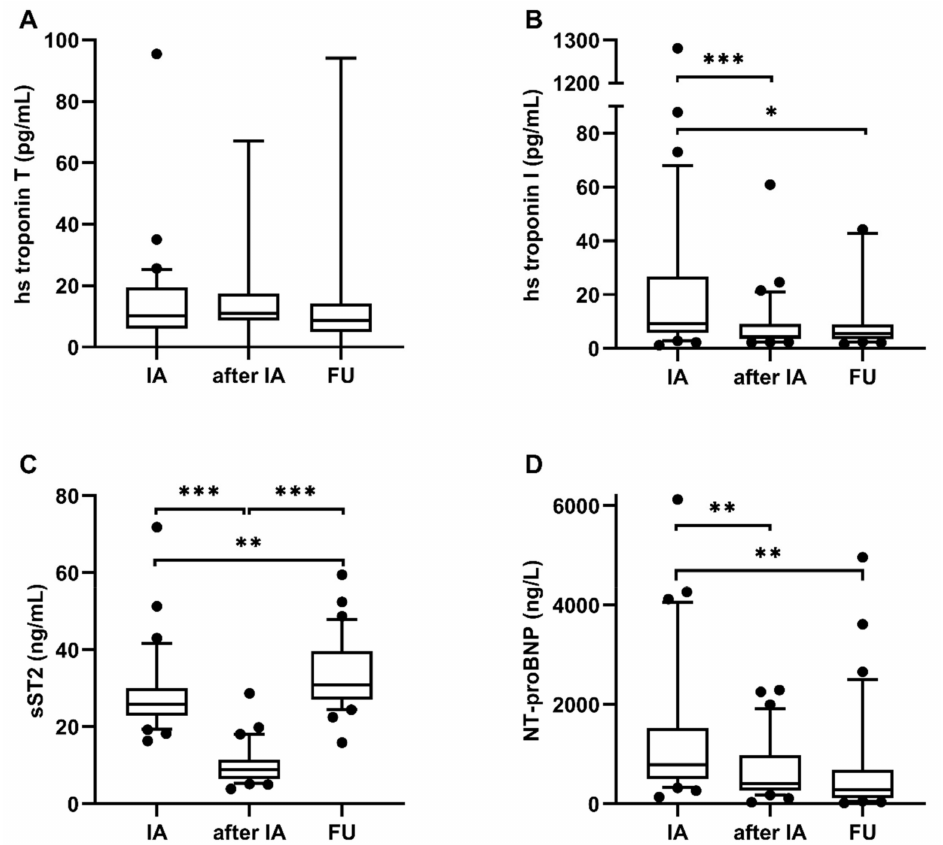
Figure 3. Course of HF biomarkers. Course of HF biomarkers (( A ) hs troponin T, ( B ) hs troponin I, ( C ) sST2, ( D ) NT-proBNP) before and after immunoadsorption treatment and at the long-term follow-up. (Boxes represent median ± IQR, whiskers represent 10–90 percentile, *** p < 0.0001, ** p < 0.005, * p < 0.05) (IA = before immunoadsorption, after IA = after immunoadsorption, FU = long-term follow-up). 3.4. Hs Troponin T, hs Troponin I and sST2 Before Immunoadsorption Correlate with LVEF at the